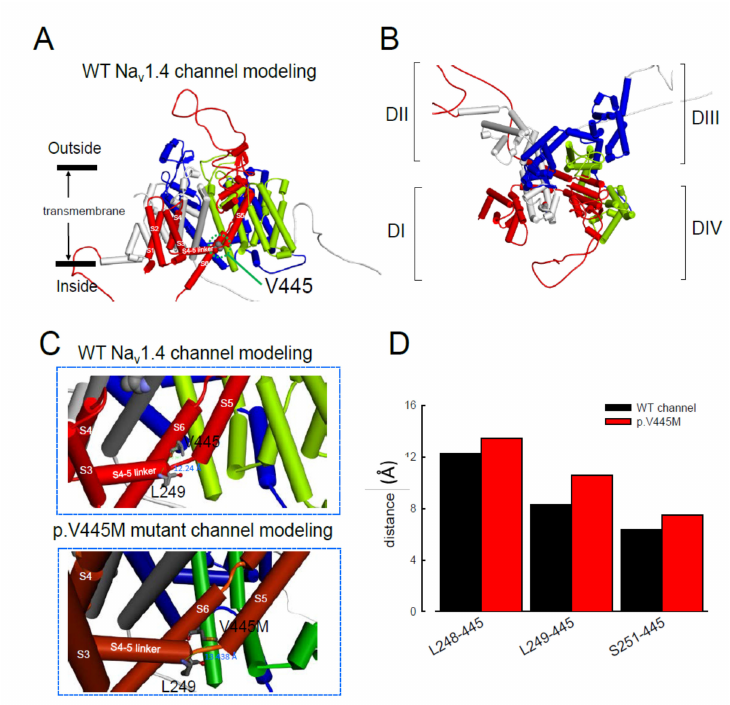
Figure 8. Homology modeling of the WT and mutant human Na v 1.4 channels. ( A ) Side view of the homology model shows the transmembrane helixes of the four domains. The four domains I, II, III and IV are colored red, white, blue and green. The side chain of V445 in the S6 linker of Domain I (DI) is indicated in the CPK model. ( B ) A closer view of the WT Na v 1.4 channel from the external side of the pore. ( C ) A diagram of Domain I of the homology model of the WT Na v 1.4 and p.V445M mutant channels is shown in the schematic presentation. The side chains of V445 in the S6 segment and L248, L249 and S251 in the S4–5 linker of Domain I are shown with sticks of various colors. A closer view of the area is shown in the panel, demonstrating inter-residue distances of ~8.3196, ~12.24 and ~6.348 Å between V445 and L248, V445M and L249 and V445 and S251, respectively, in the WT Na v 1.4 channel, while the distances between p.V445M and L248, p.V445M and S249 and p.V445M and S251 are ~7.54, ~13.438 and ~10.551 Å, respectively, in the p.V445M mutant channel. ( D ) The relative distances between the residue V445 and L248, L249 and S251 in the homology modeling is shown. Note the conspicuously decreased distances in all cases in the WT channel compared with those in the p.V445M mutant